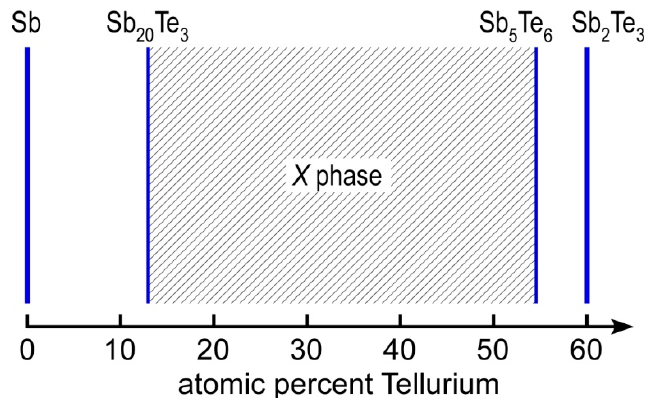
Figure 4. The X phase composition region in the Sb–Te binary system.